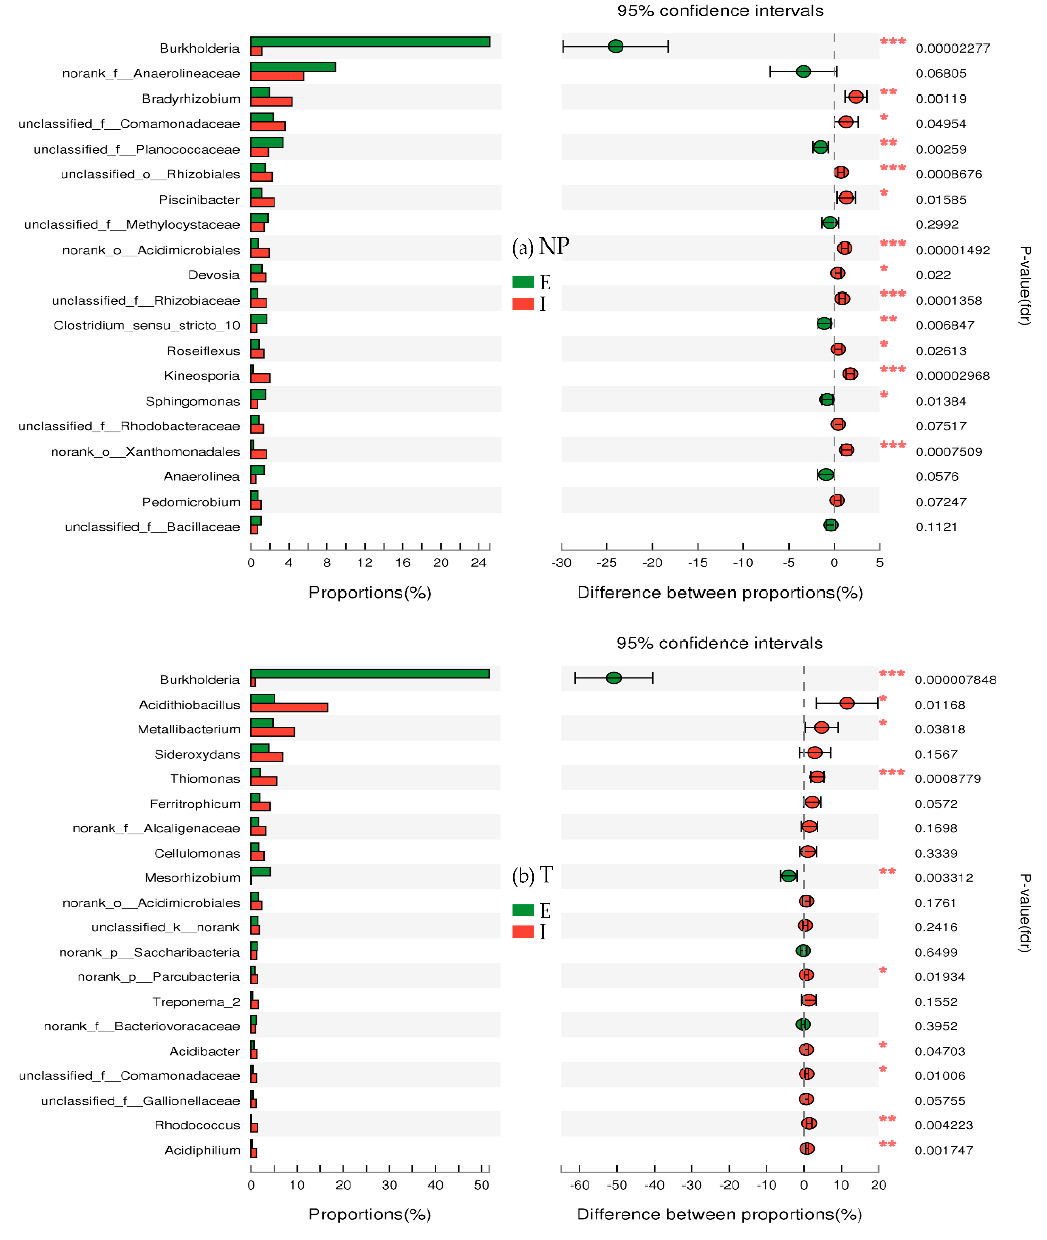
Figure 7. Differences in species abundances between the external layer (E) and internal layer (I) of iron plaque in ( a ) the non-polluted soil (NP) and ( b ) the tailing soil (T). (* 0.01 < p ≤ 0.05, ** 0.001 < p ≤ 0.01, *** p ≤ 0.001).